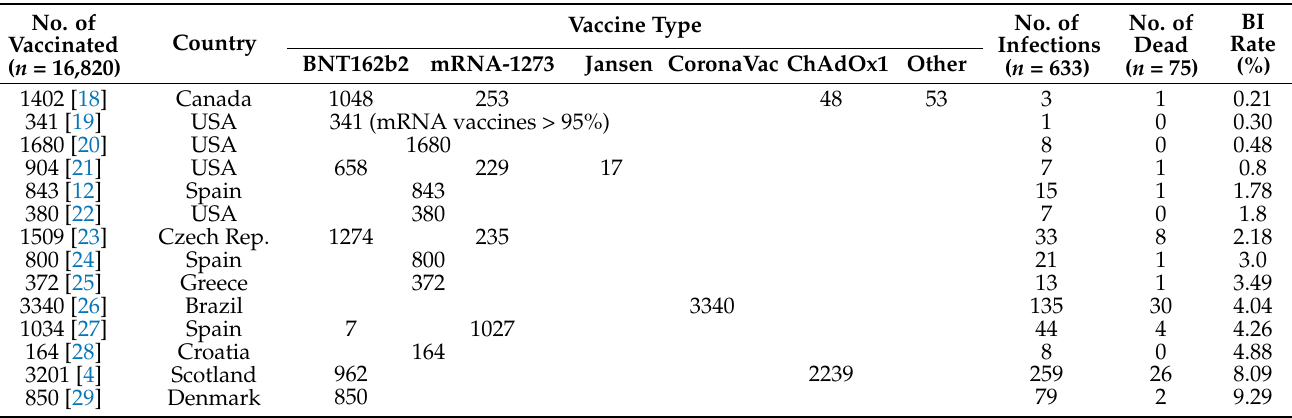
Table 1. Center-level summary of SARS-CoV-2 breakthrough infections in